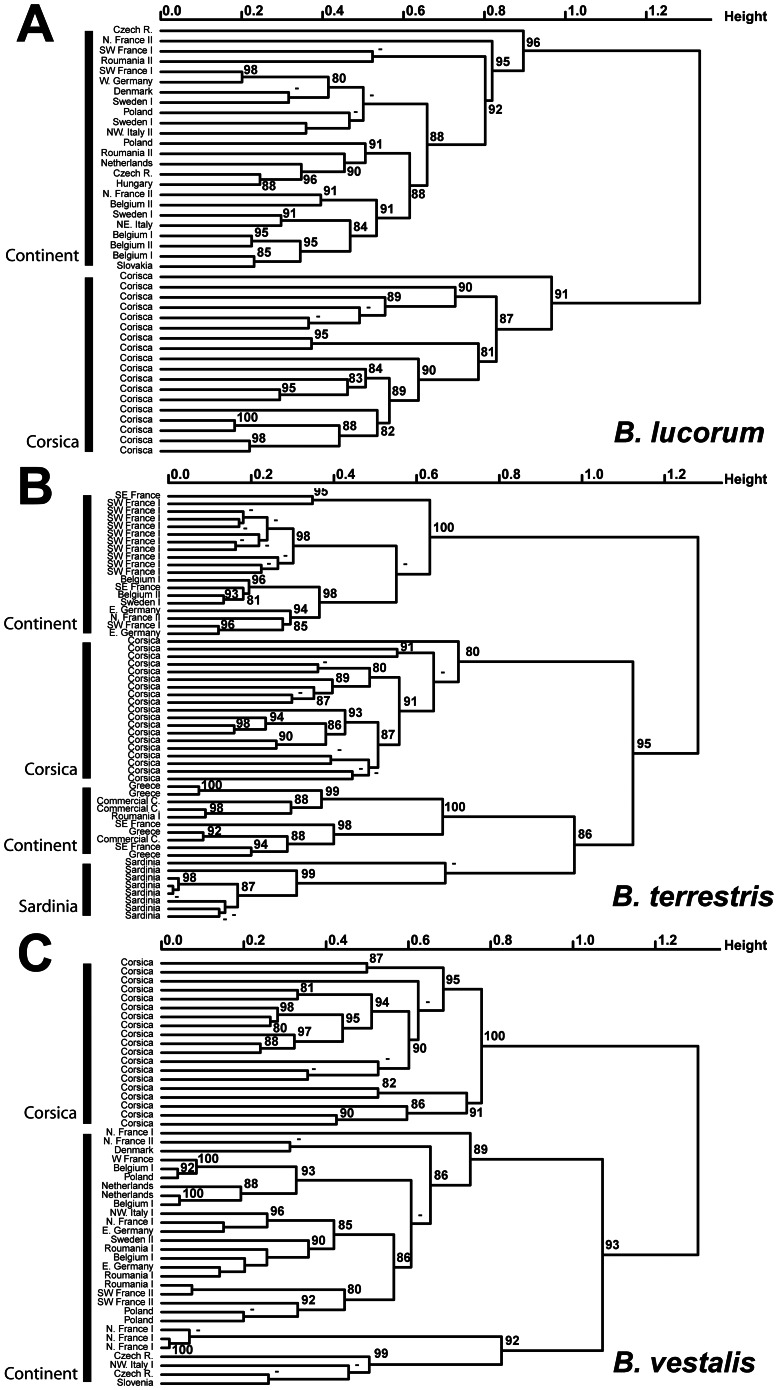
Unweighted pair group method with arithmetic mean (UPGMA) cluster based on a correlation matrix calculated from the matrix of male marking secretion.A = B. lucorum (55 compounds X 42specimens); B = B. terrestris (105 compounds X 56 specimens); C = B. vestalis (56 compounds X 48 specimens). Values above branch represent multiscale bootstrap resampling (only values >80% are given).